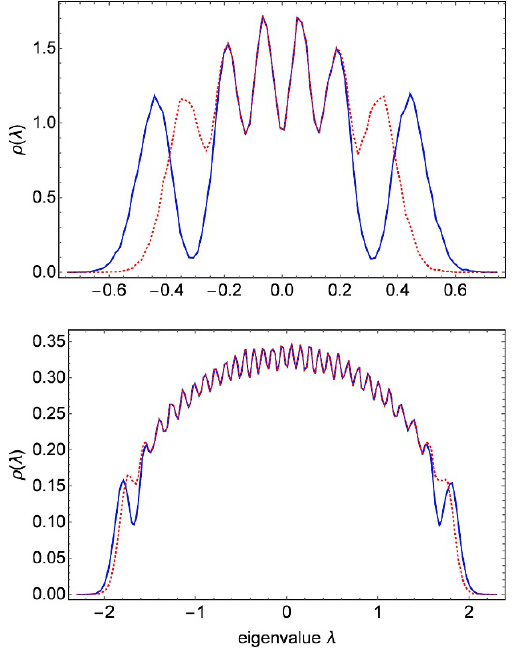
Figure 4 . Top panel: the distribution (cid:26) eig curve), for N = 6, h = 0 : 3 and quench parameter (cid:15) = 0 : 1. Bottom panel: same as above with N = 30, (cid:27) = 1 = 8 and (cid:15) = 0 :